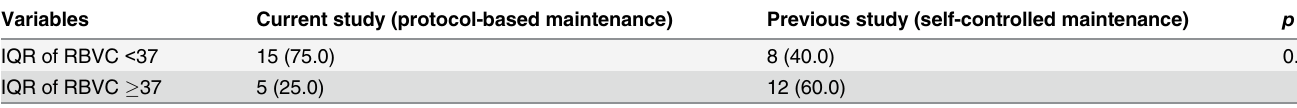
Table 6. Biofeedback effect relative to bladder volume